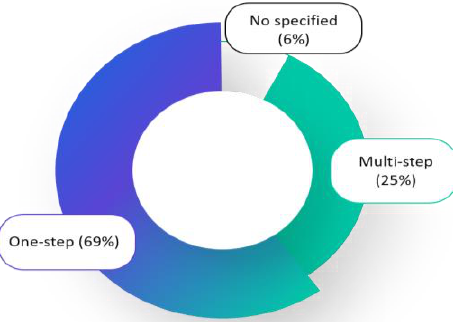
Figure 21. Classification by steps ahead.